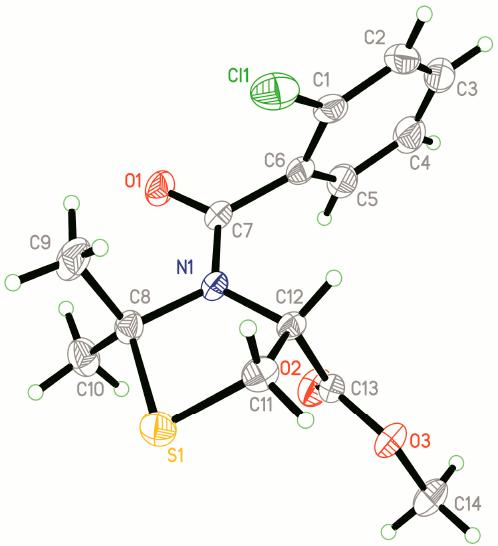
Figure 1. Molecular structure for Compound 4q at 30% probability level.